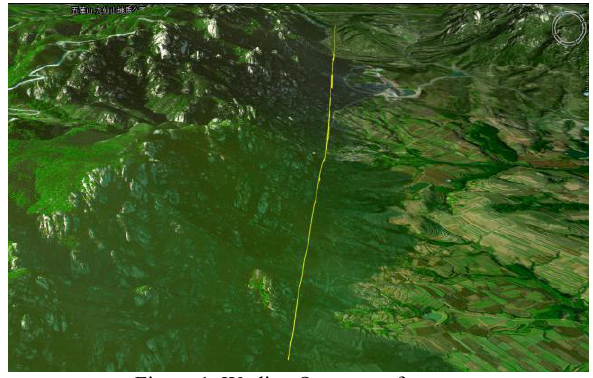
Figure 1. Wadian Quanyuan fracture